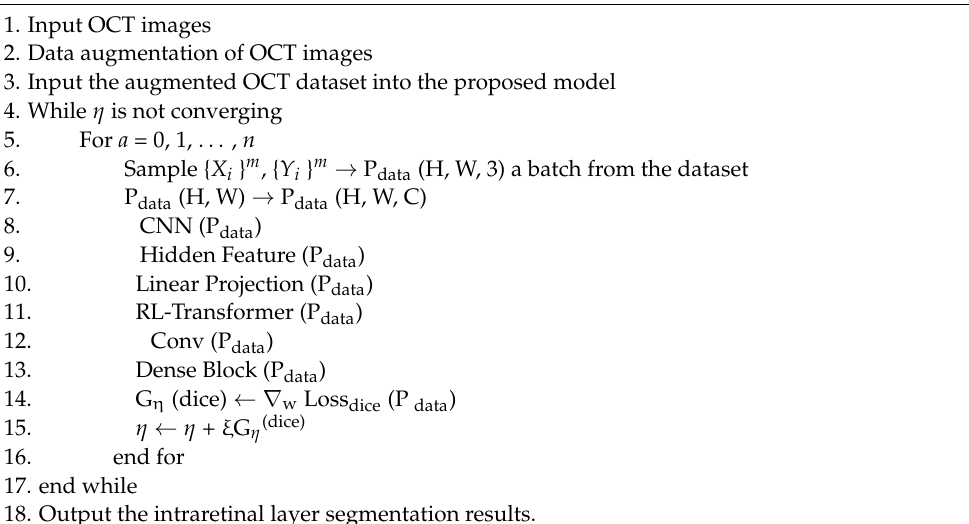
Algorithm 1 The proposed algorithm for fundus OCT intraretinal layer